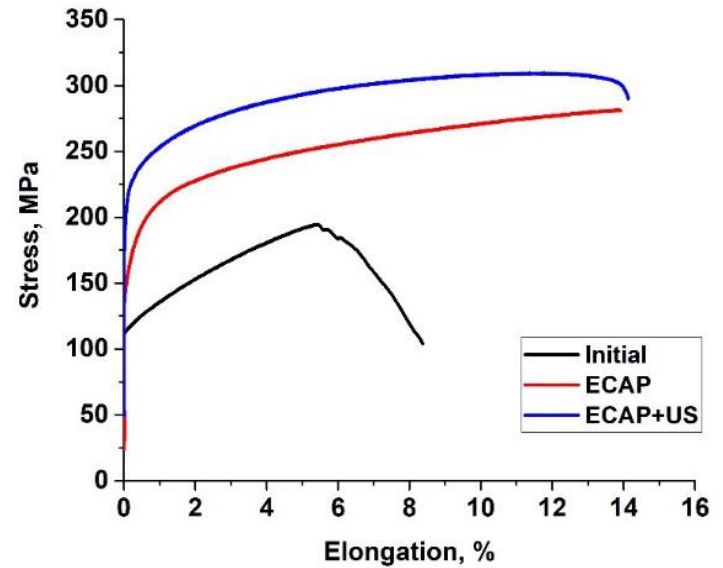
Table 3. Mechanical properties of Mg-Al-Zn alloy.